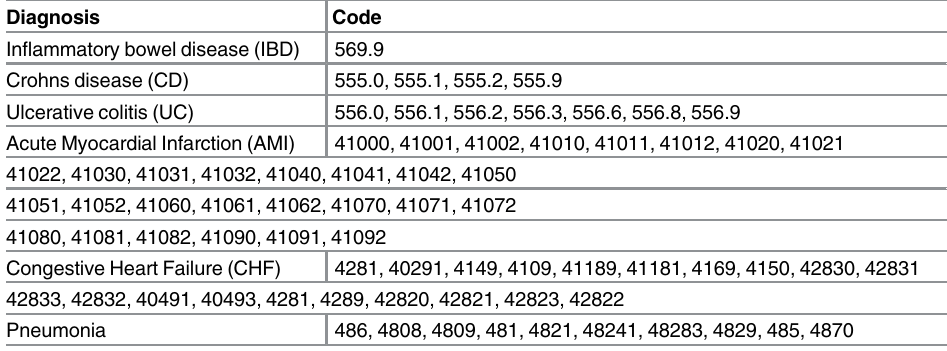
Table 1. ICD-9-CM Diagnostic Codes Used to Identify Primary and Co-diagnoses. Diagnosis